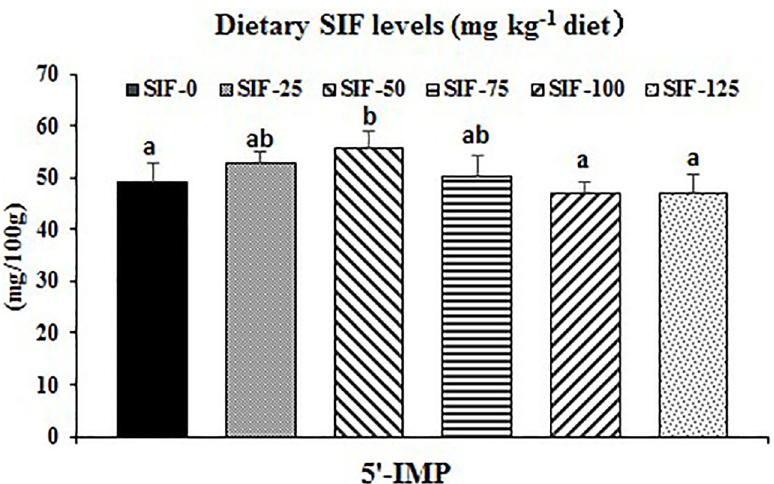
Fig 1. Effects of SIF on the 5’-IMP in the muscle of grass carp. All data were expressed as means ± SD (n = 6). Mean values within the same row with different superscripts are significantly different ( P < 0.05). 5’-IMP, 5’-inosine monophosphate.